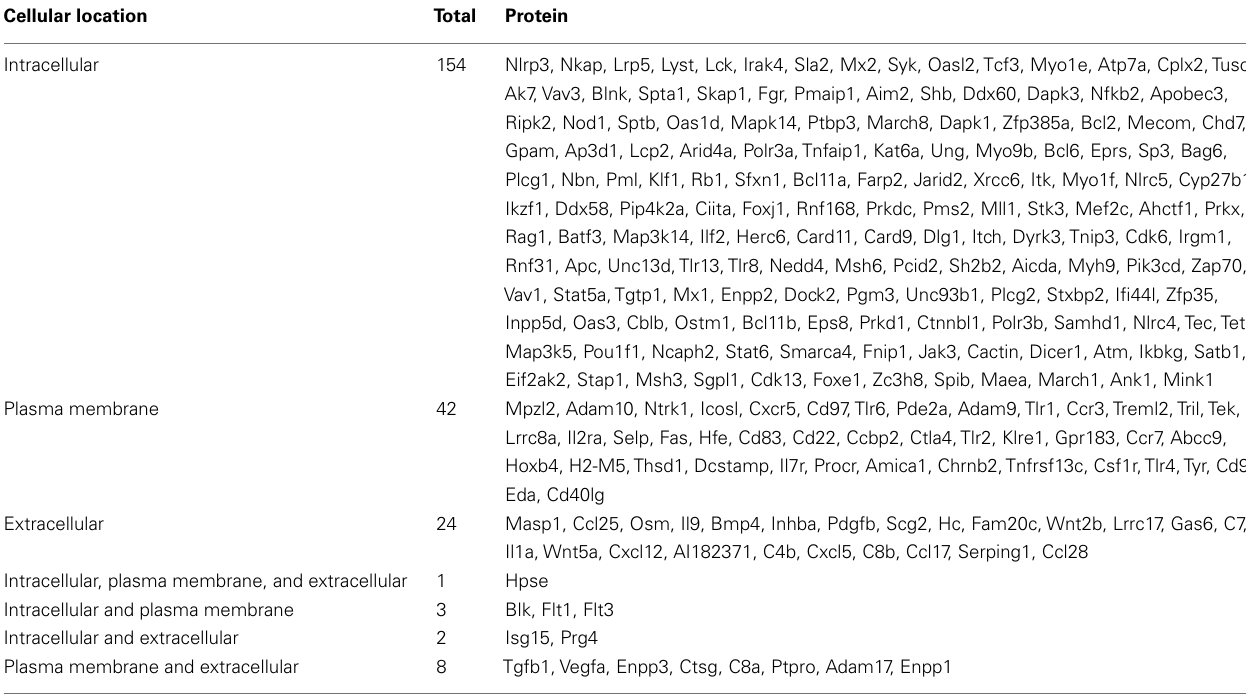
List of murine proteins that carry “consensus” heparin/HS-binding motifs.The motifs adapted for bioinformatic screens are the standard motifs, which are primarily XBBBXXBX or XBBXBX (17) (http://gduserv.anu.edu.au/~cameron/protein.html). Short motifs are truncated versions of the standard motifs XBBBBX, BBXBB, or BBXXXBB (B = basic amino acids R, K, H; X = A, V, I, L, M, F,Y, W). Only proteins in the UniProt database (www.uniprot.org) that are known to play immunological roles are